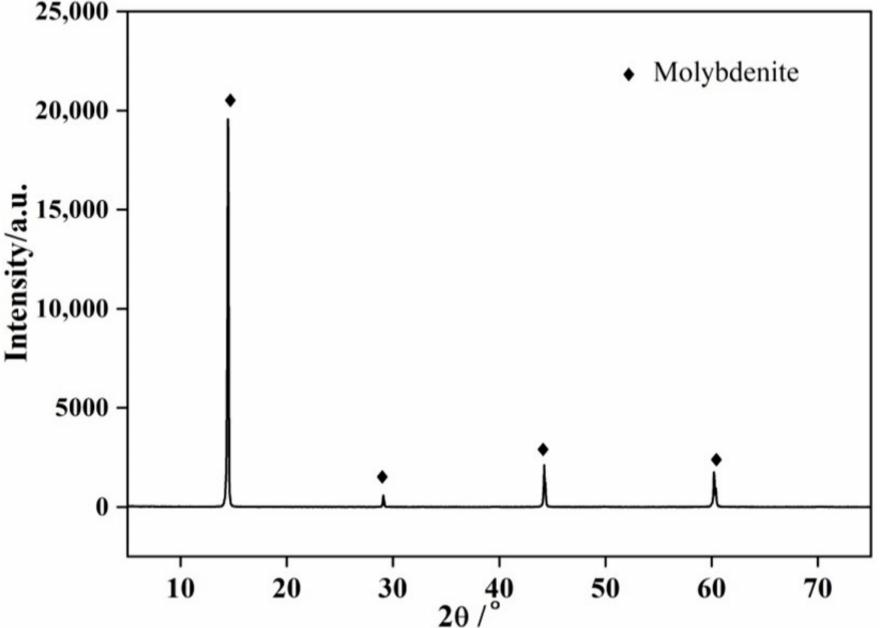
Figure 1. X-ray diffraction (XRD) analysis of molybdenum single mineral sample.